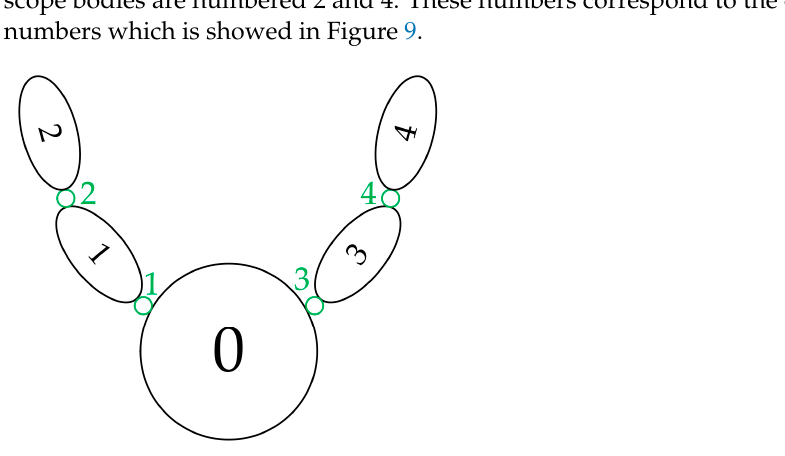
Figure 7. Reference coordinate systems. ( a ) Satellite coordinate systems; ( b ) telescope coordinate systems.